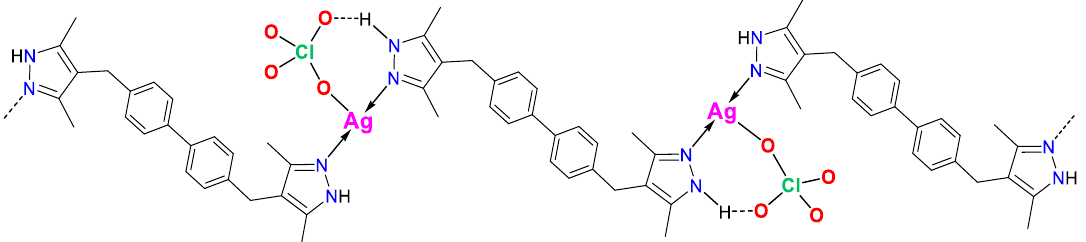
Figure 8. Proposed polymeric structure of [Ag(H 2 DMPMB)(ClO 4 )] ( 5 ), evidencing the T-shaped stereochemistry of silver(I) ions assured by the perchlorate anions and the neutral ligands coordinated in a bridging exo-bidentate mode.